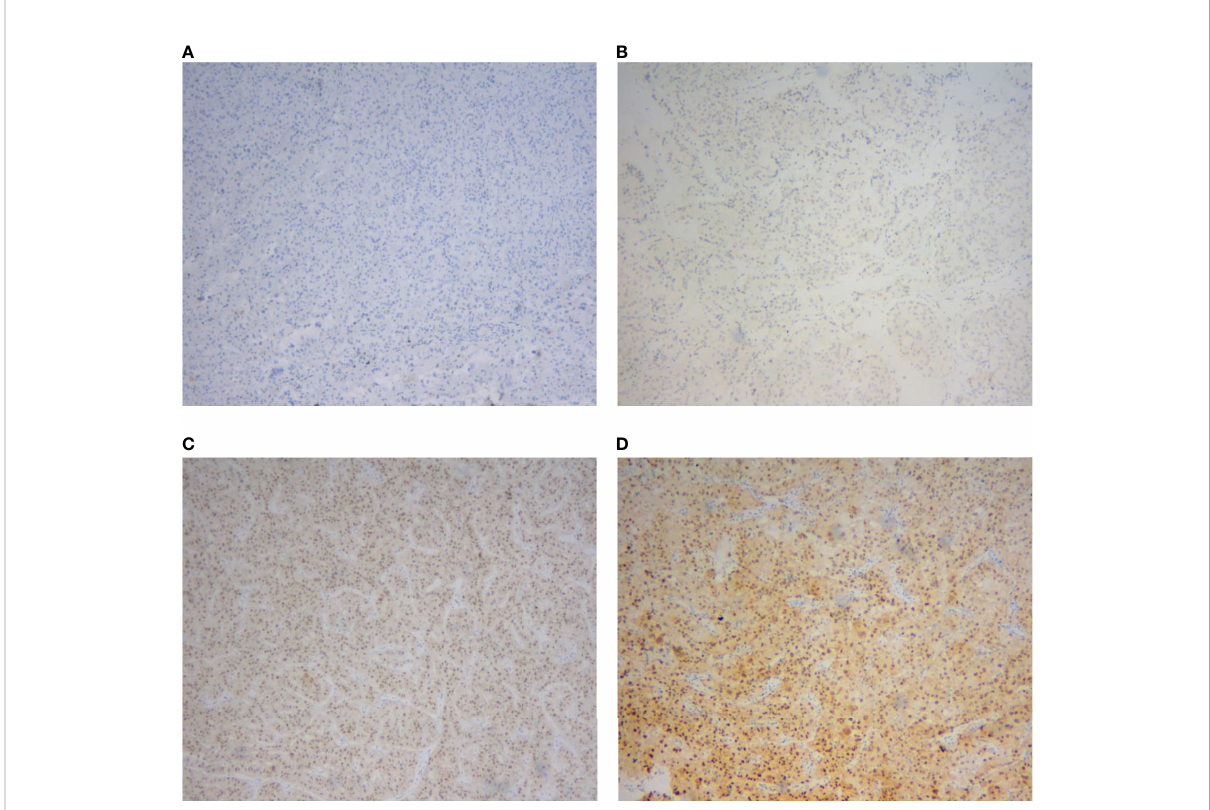
FIGURE 1 Immunohistochemical staining of TFE3 protein in renal cell carcinomas. (A) Negative expression. (B) Weak expression. (C) Moderate expression. (D) Strong